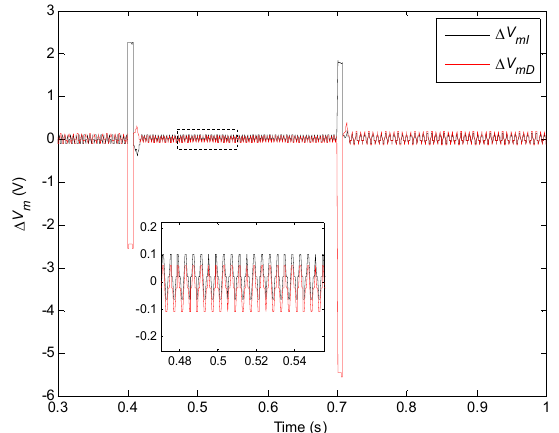
Figure 28. curves under two conditions.